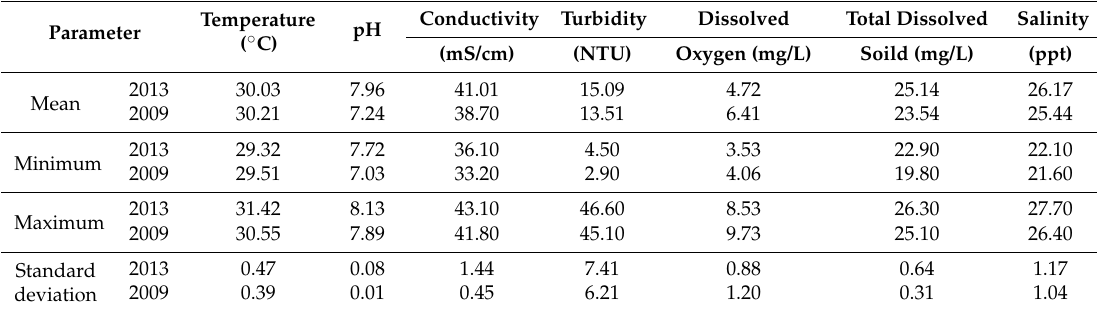
Table 13. Measurement of water quality parameters at 36 points on Merambong shoal and